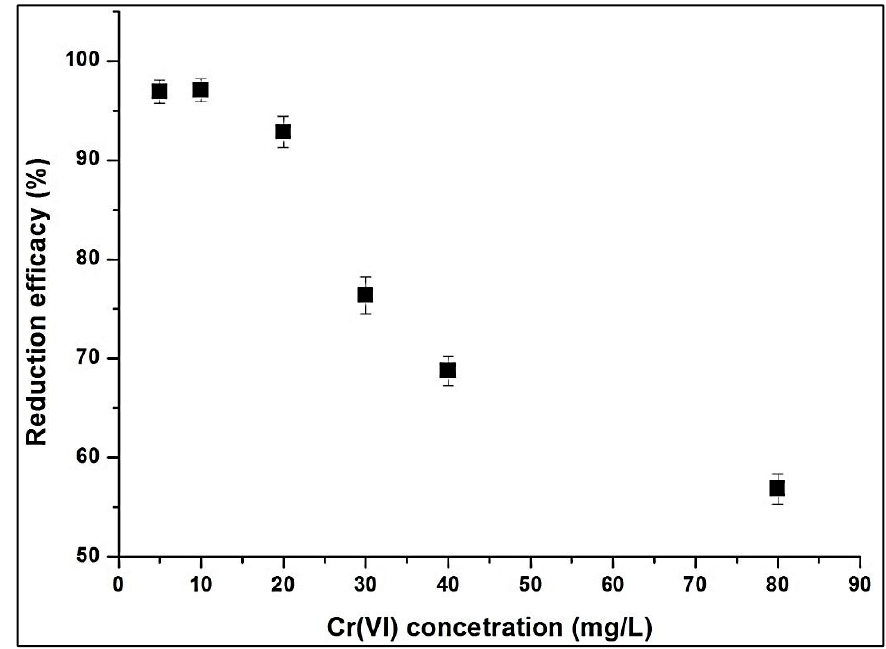
Figure 7. Effects of initial Cr(VI) concentration: [Cr(VI)] 0 = 5–80 mg · L − 1 , Cr(VI) volume = 25 mL, contact time = 60 min, pH = 2, PLE quantity = 1.5 mL.